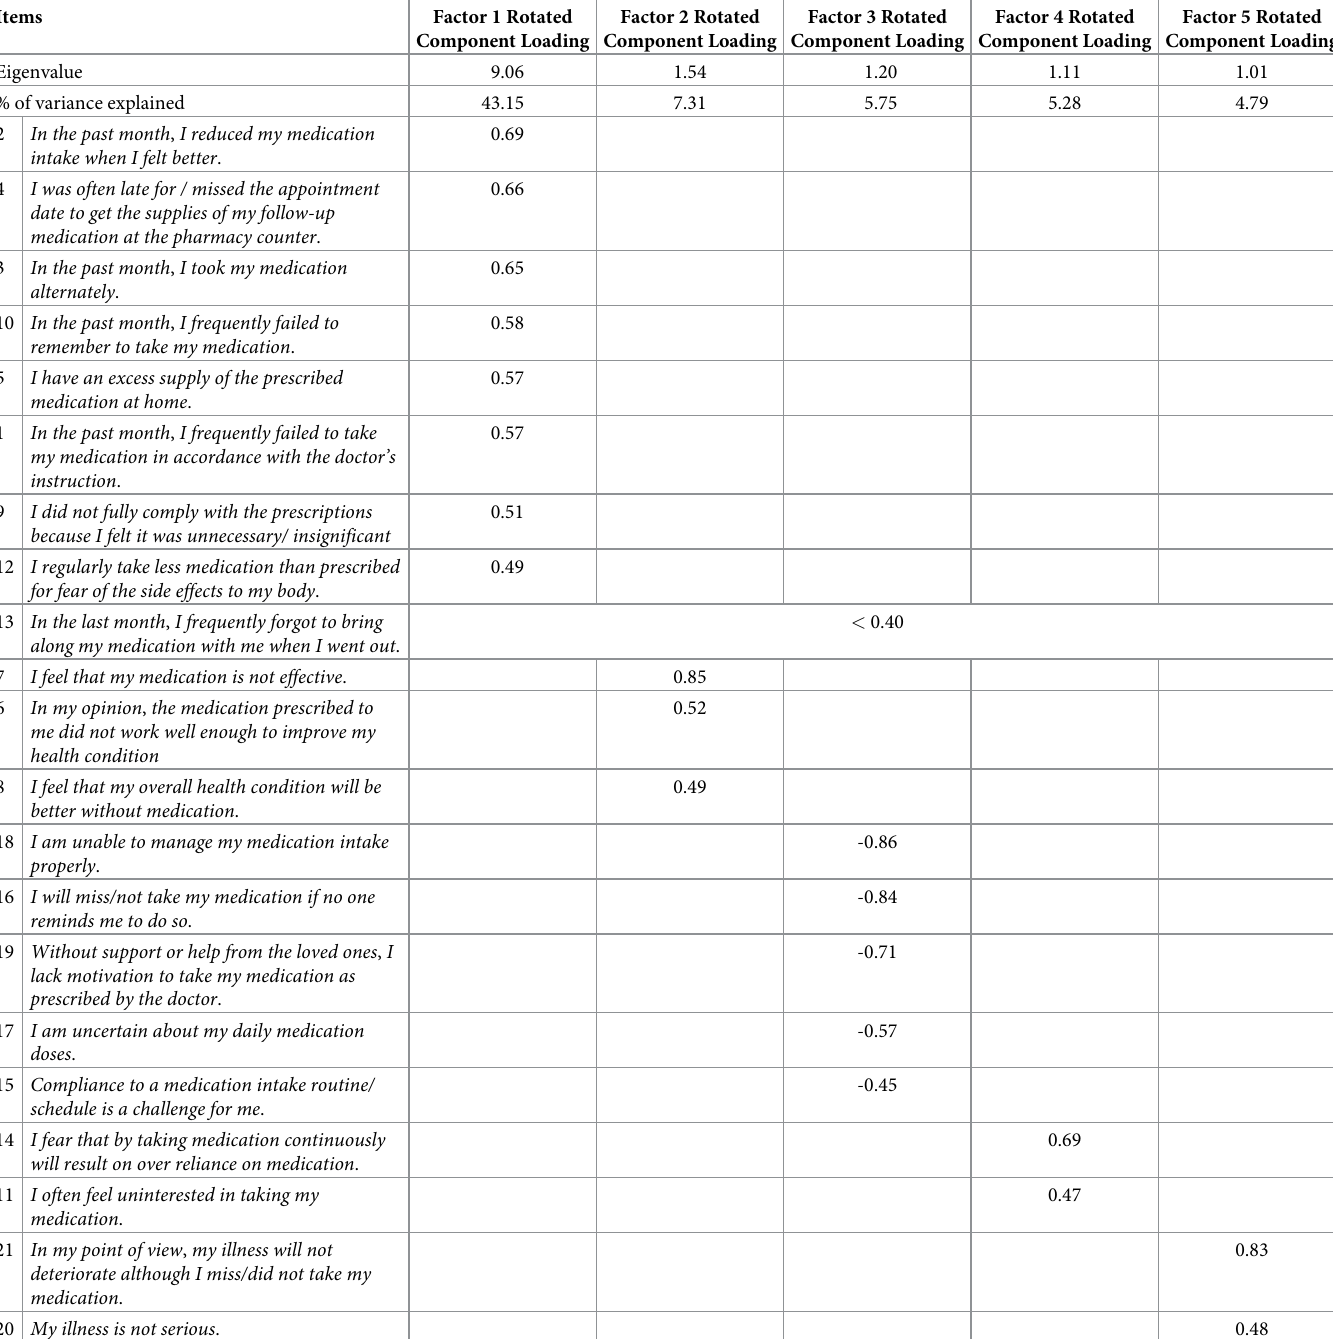
Table 3. Factor analysis for original scale (Direct Oblimin Rotated Component